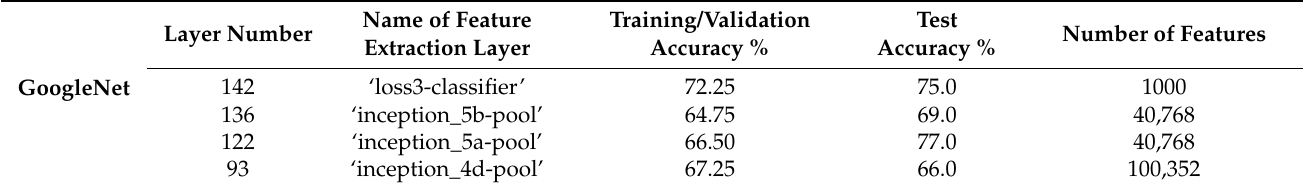
Table 7. Classification performance of SVM using the autonomous features from GoogleNet.